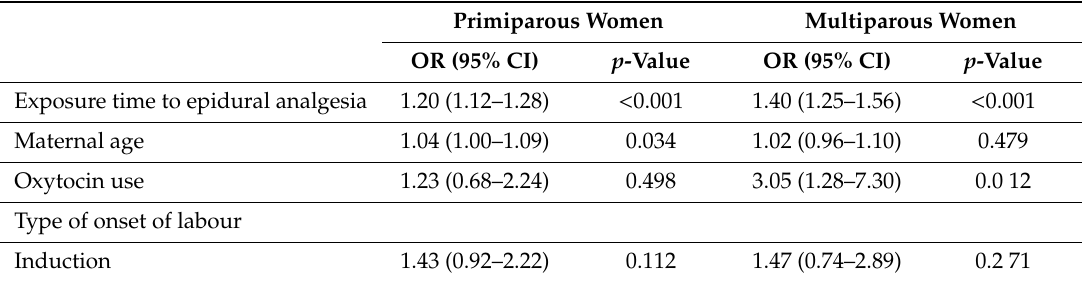
Table 4. The adjusted OR non-spontaneous birth by parity. Primiparous Women Multiparous